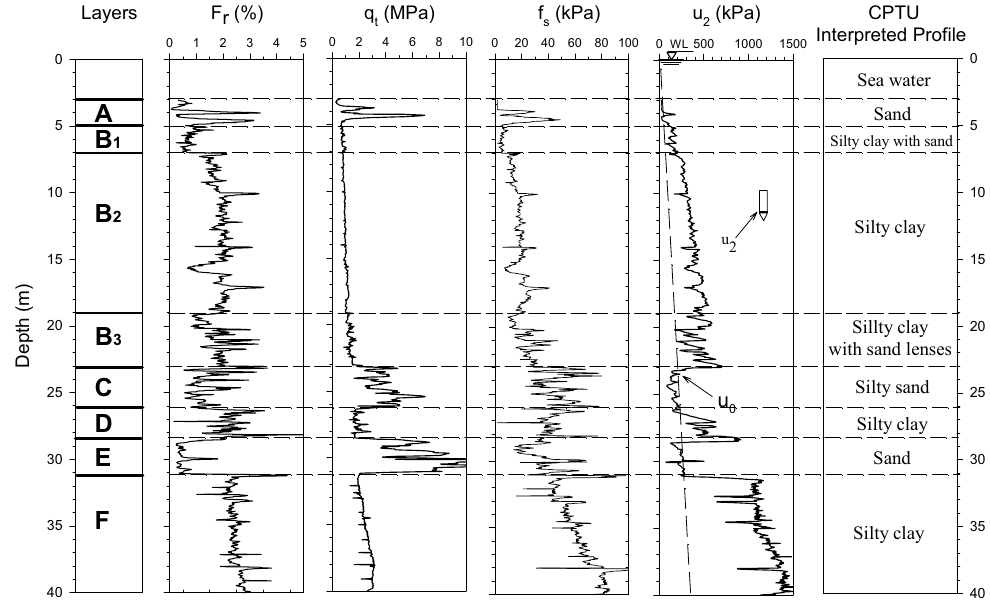
Fig. 11 – Interpretation of a piezocone test result carried out at Guarujá bay site.